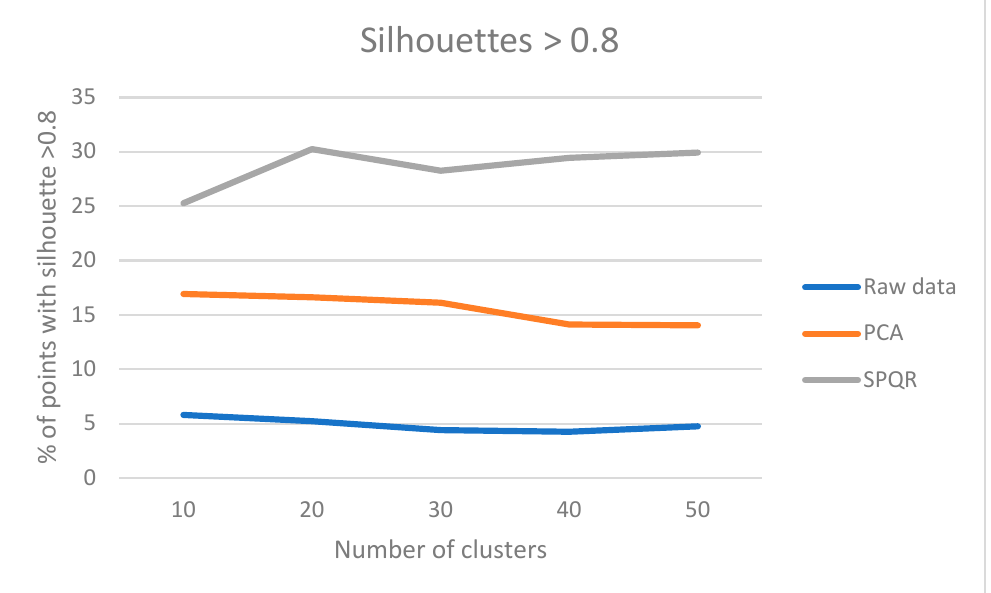
Figure 5. The mean results in terms of silhouettes >0.8 obtained varying the number of clusters from 10 to 50 using normalized data.